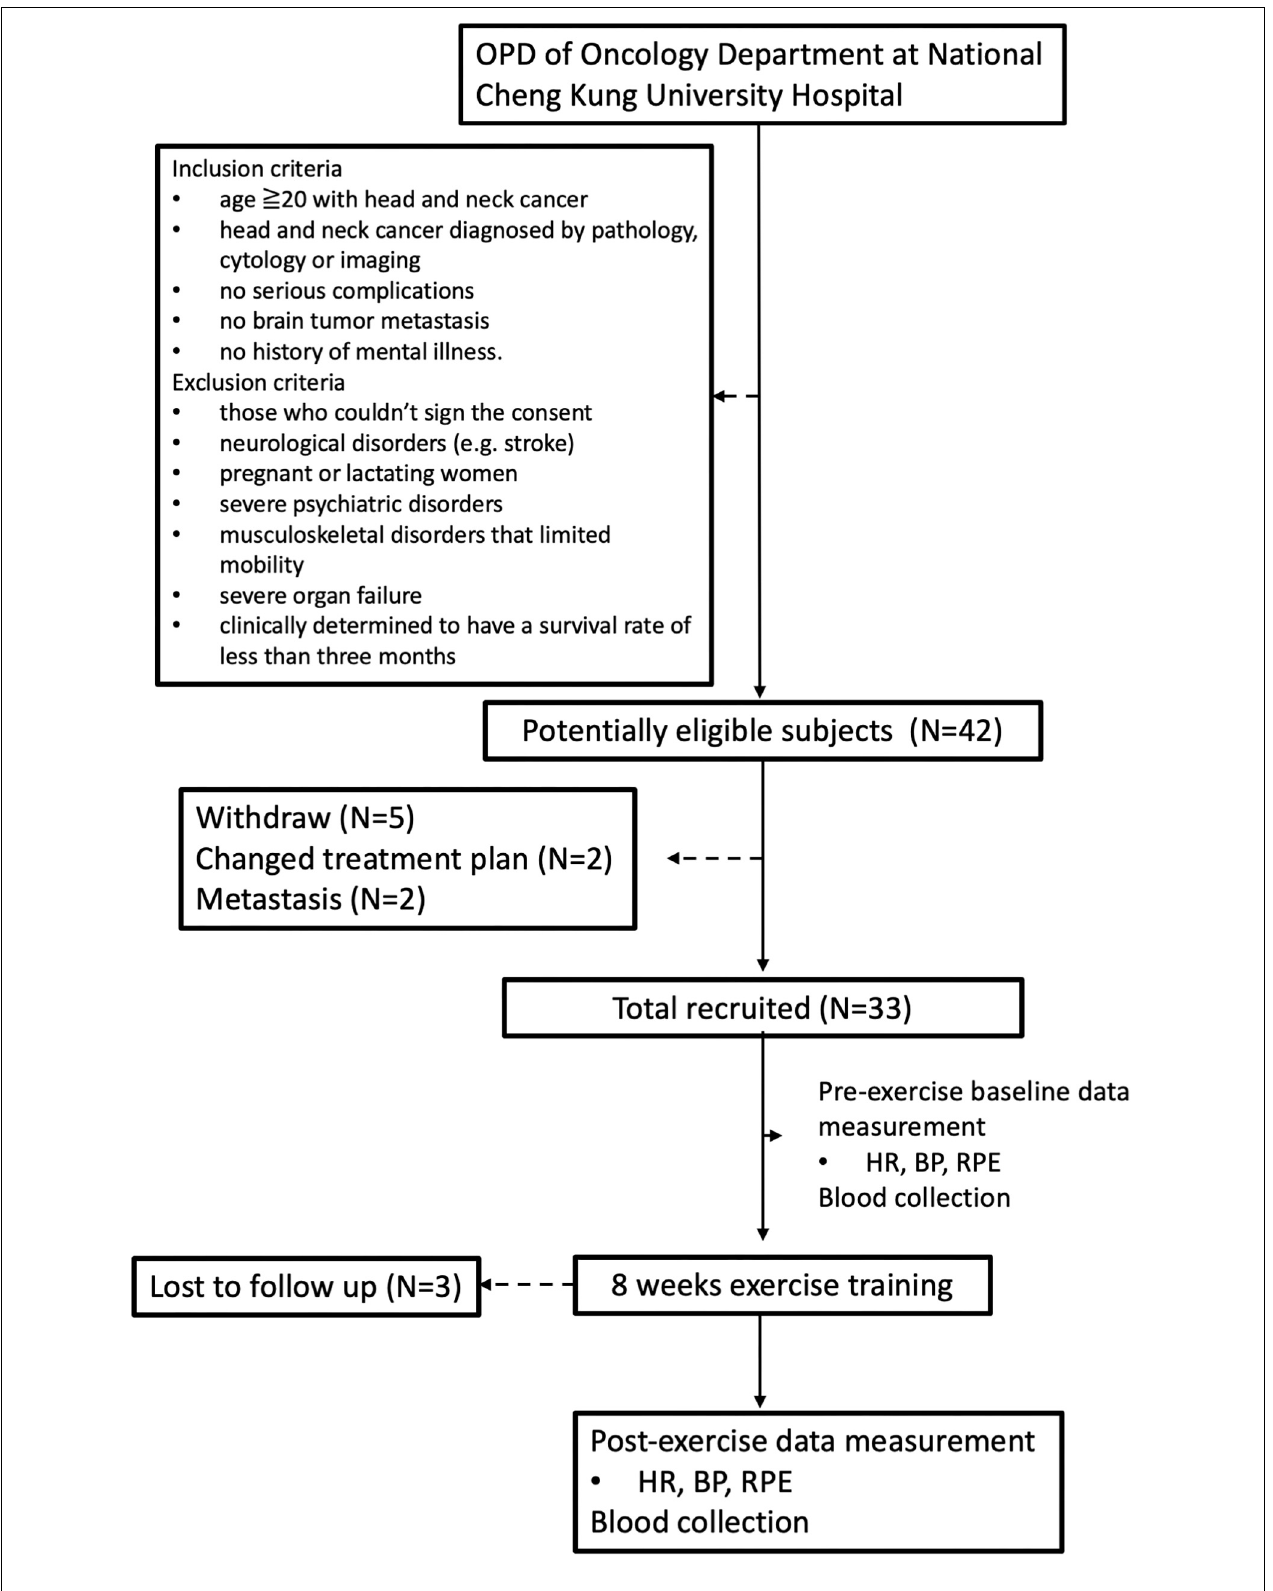
FIGURE 1 | Flow of participants through the trial.